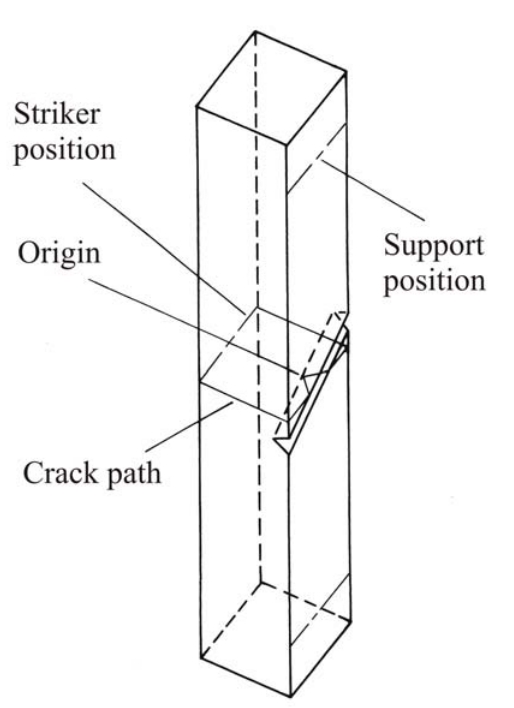
Figure 14. Angle notch Charpy specimen, crack origin at cen- tre of notch.